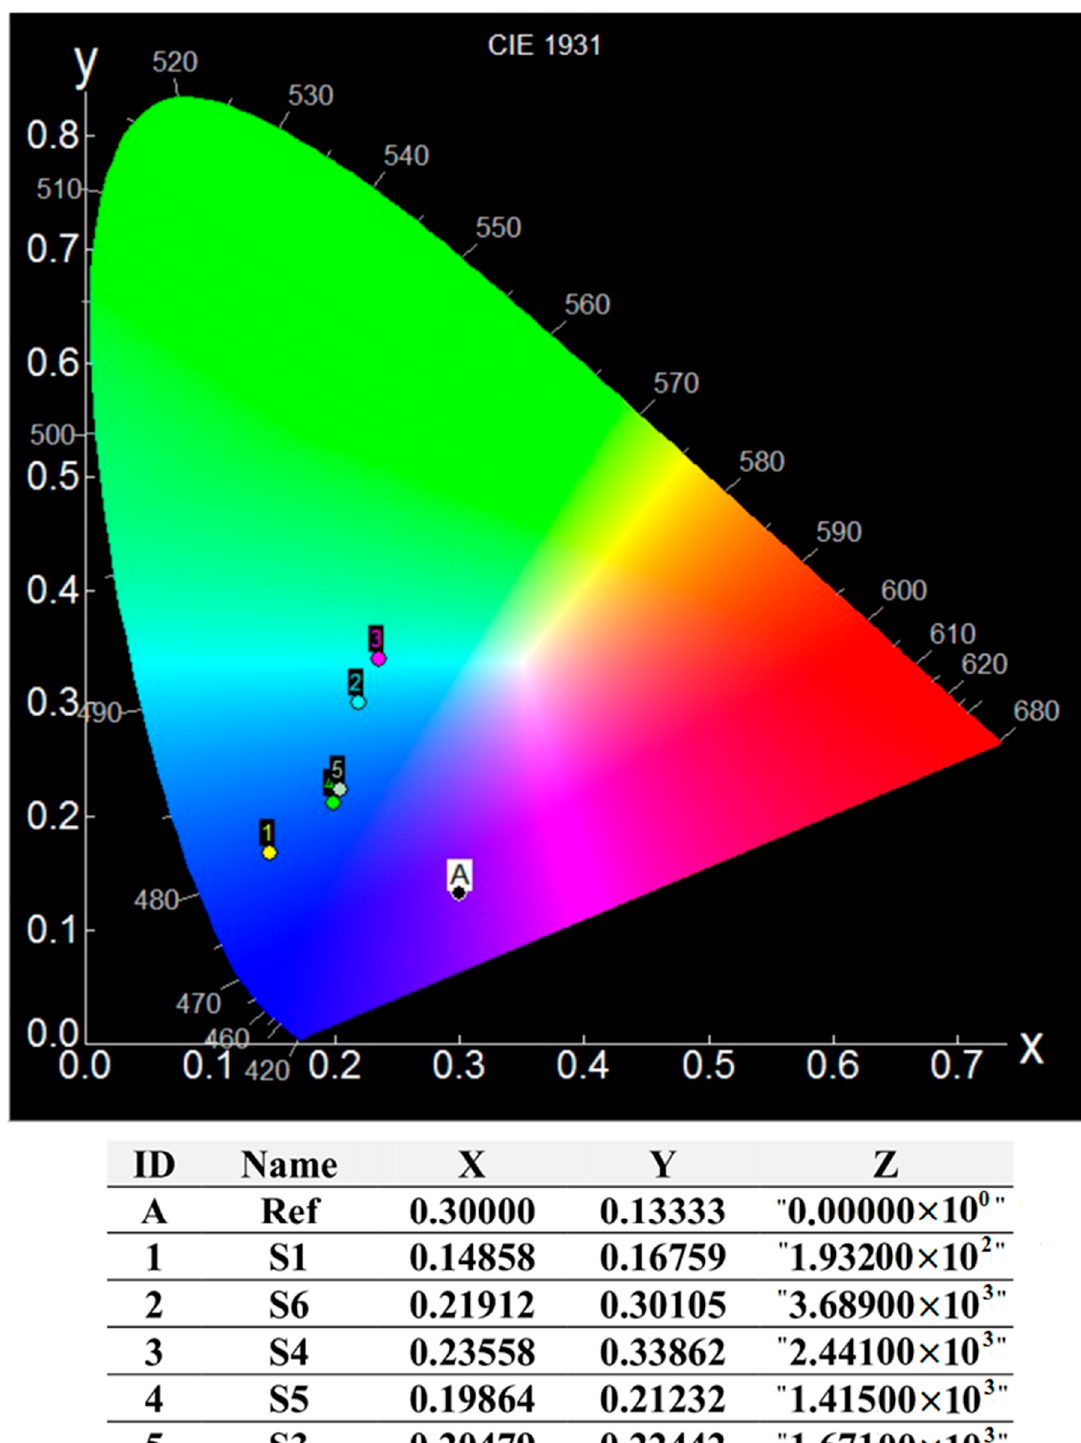
Figure 9. The CIE color chromaticity diagram of pure ZnO and MoO 3 - incorporated ZnO